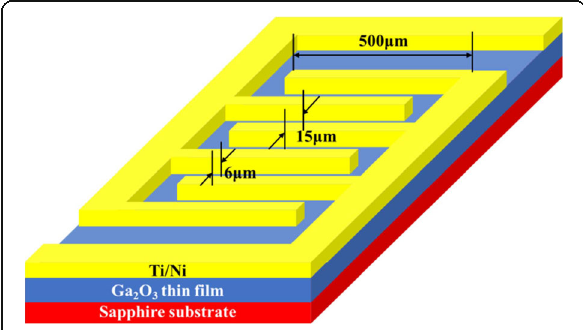
Fig. 1 The schematic of the photodetector based on poly-Ga 2 O 3 thin film